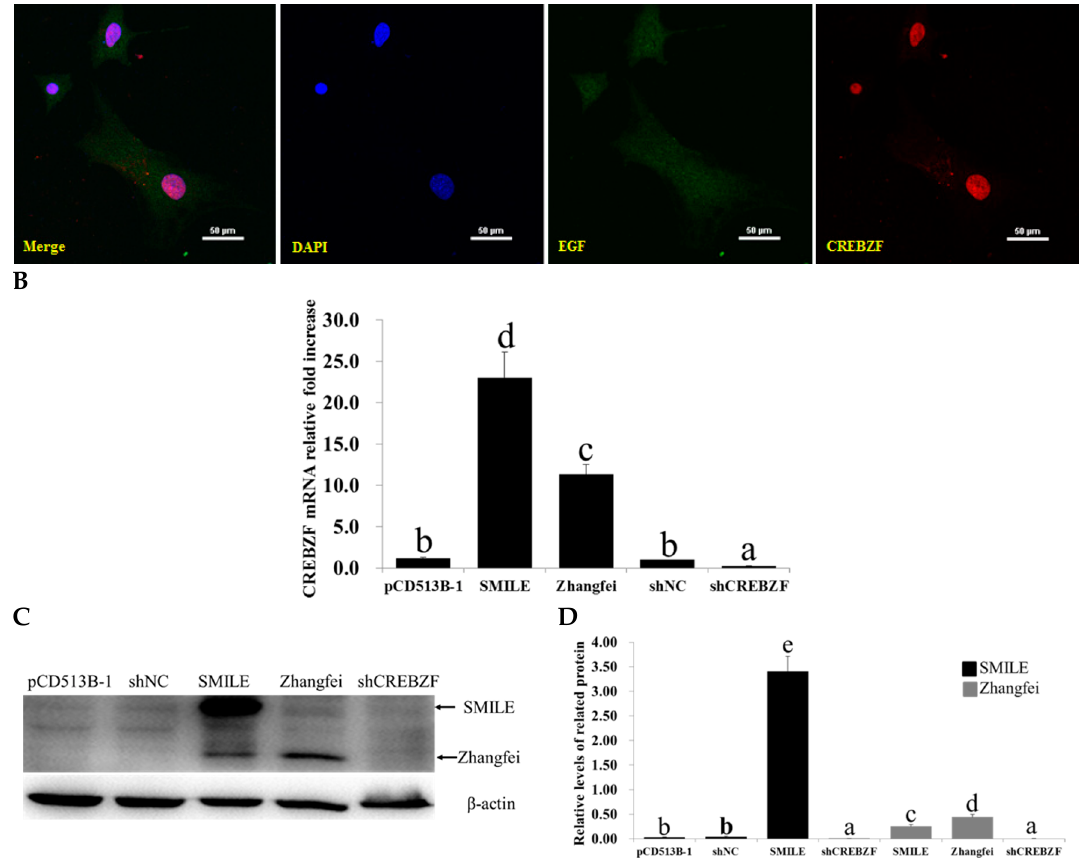
Figure 2. CREBZF expression in primary mouse ovarian granulosa cells after transduction of CREBZF lentiviruses. ( A ) Immunofluorescence analysis of CREBZF expression levels in ovarian granulosa cells transduced with CREBZF lentivirus for 48 h. Scale bars, 50 μ m; ( B ) relative mRNA expression of the CREBZF gene in ovarian granulosa cells transduced with CREBZF lentivirus for 48 h. The amounts of mRNA were normalized to that of β -actin; ( C , D ) western blot analysis of SMILE and Zhangfei expression levels in ovarian granulosa cells transduced with CREBZF lentiviruses for 48 h. The statistical analysis is shown in the bar graphs. Data are presented as the mean ± SEM. The bars with different letters show significant differences ( p < 0.05), while the bars with the same letter show no difference between their respective